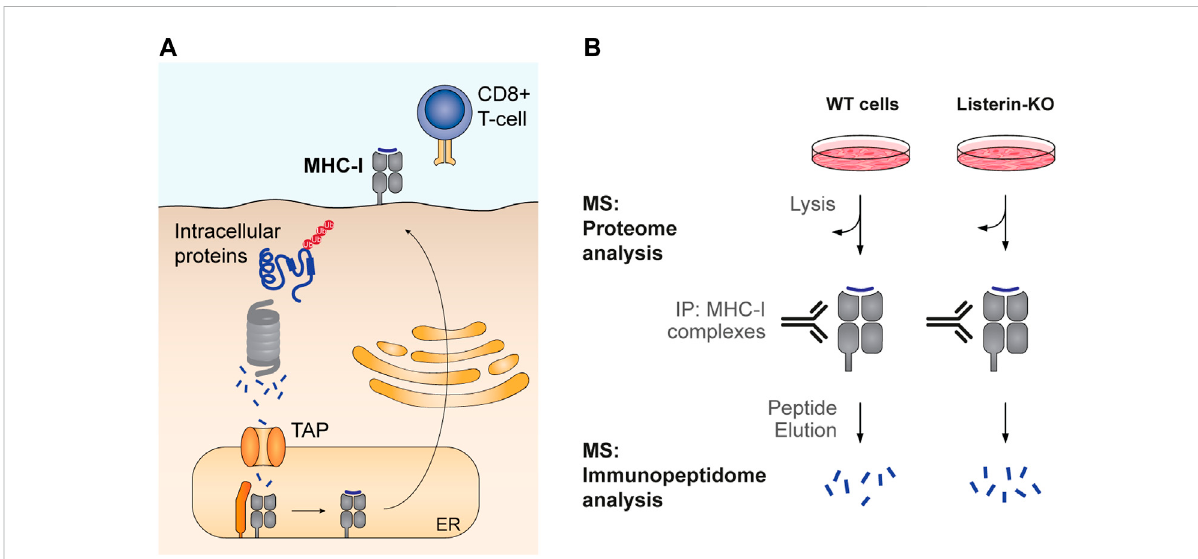
FIGURE 5 AnalysisofMHC-Iantigenpresentationasaproxyforproteindegradation. (A) Cytosolicpeptidesproducedbytheproteasomearetranslocated into the ER lumen by the Transporter associated with Antigen Processing (TAP). There, they are loaded into the MHC-I complex, which is then transportedto thecellsurfaceforinspectionbycytotoxicTcells. Accordingly, MHC-Ipresentationcorrelates withthelevels ofintracellularpeptides produced by proteasomal degradation. (B) High-throughput analysis of MHC-I antigen presentation. Trentini et al. quanti fi ed the repertoire of immunopeptides in WT and Listerin-KO human cells by immunoprecipitation of MHC-I with bound peptides. Peptides were released from the complex by solvent elution and then analyzed by mass spectrometry (MS). An aliquot of the total protein extract was collected for trypsin digestion and total proteome analysis. Comparison between proteome and immunopeptidome WT to KO ratios allows assessing whether changes in antigen presentation stem from differential protein expression or from alterations in proteasomal